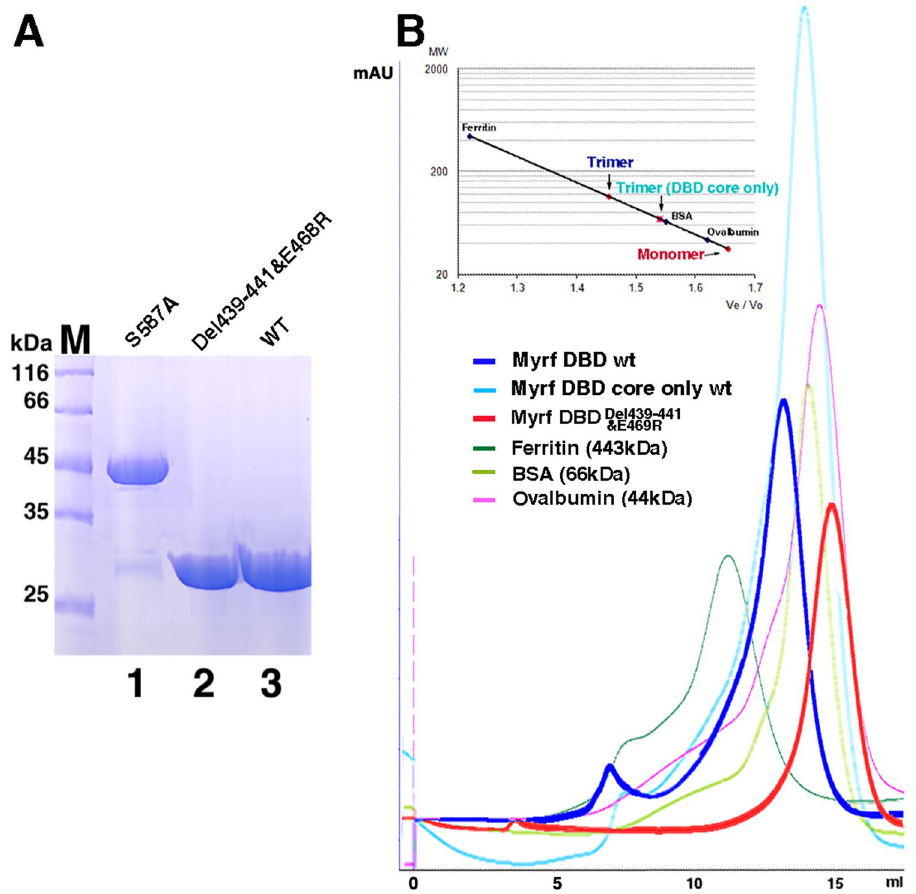
Figure 4. MyRF DBD mutation disturbs trimer formation but does not affect auto-cleavage of MyRF. ( A ) The auto-cleavage of MyRF and its mutants were analyzed by 12% SDS-PAGE. M: protein marker. ( B ) Elution profiles from gel filtration chromatography of MyRF DBD and its mutant. Calibration curve of proteins with known molecular weights (ferritin (443 kDa), bovine serum albumin (BSA; 66 kDa), chicken ovalbumin (44kD); Sigma-Aldrich) was shown. The molecular weight of these proteins was plotted against their calculated Ve/Vo and fitted by exponential regression analysis. On the basis of the calculation, the Ve/Vo of wild type MyRF DBD results in a molecular weight of 110 kDa, and the Ve/Vo of its mutant results in a molecular weight of 35 kDa, indicating the trimeric and the monomeric form of protein respectively. The Ve/Vo of wild type MyRF DBD core only (after treated by limited proteolysis of trypsin) results in a molecular weight of 70 kDa, indicating the trimeric form